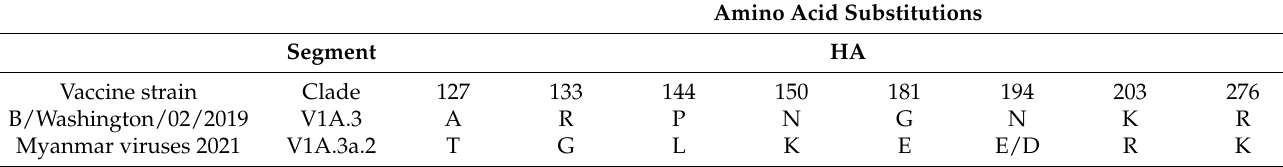
Table 4. Common amino acid substitutions in the HA segment of the B/Victoria viruses collected in Myanmar in 2021 compared with those of the SH 2021 vaccine strain